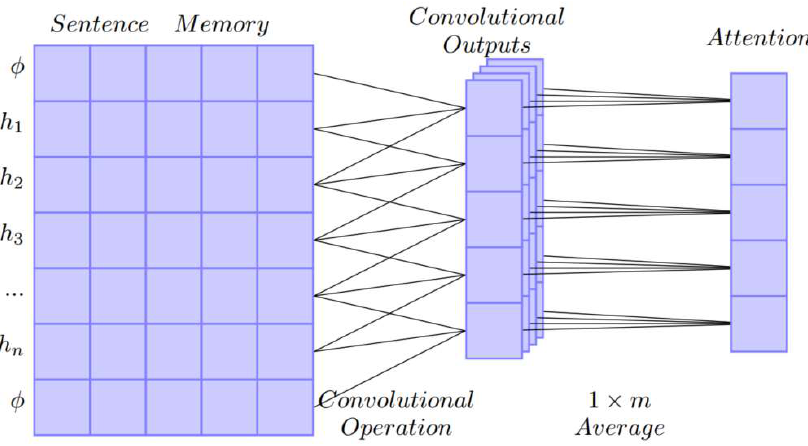
Figure 3. CNN-based model of attention signal extraction.